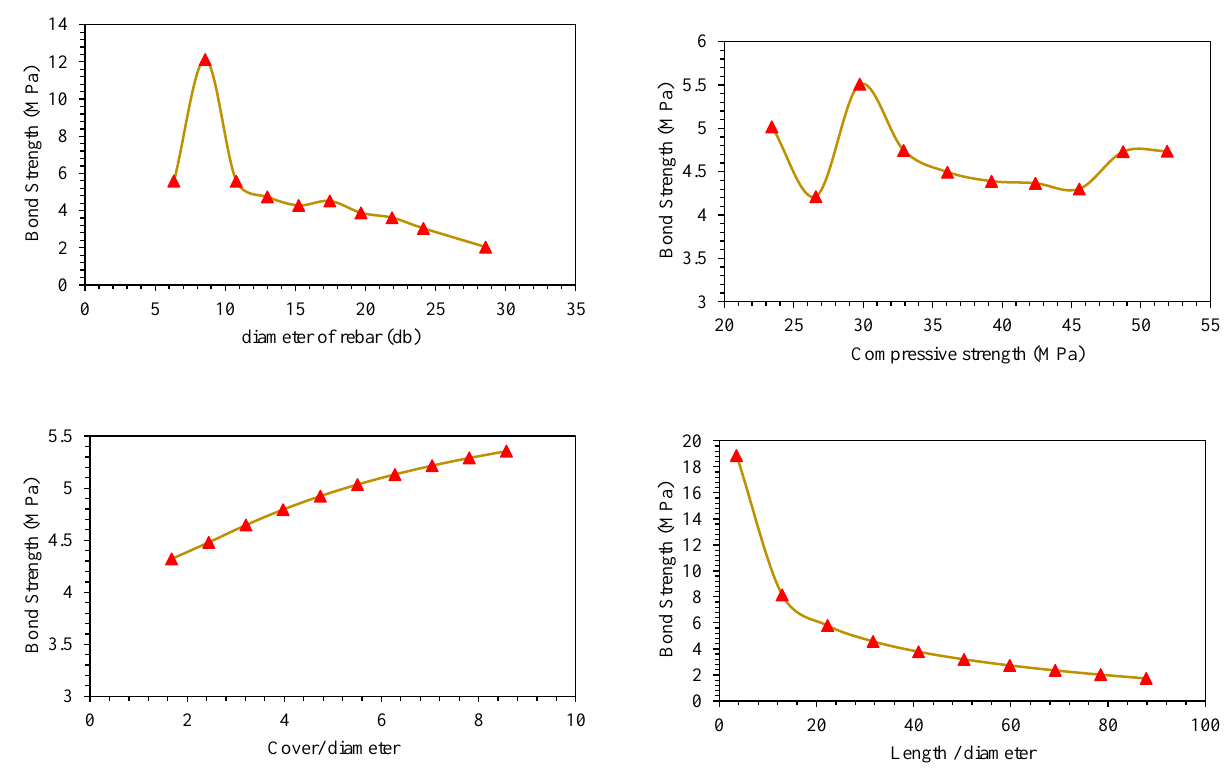
Figure 15. Effect of the contributing parameters on BS for B p type-II and B s type II.